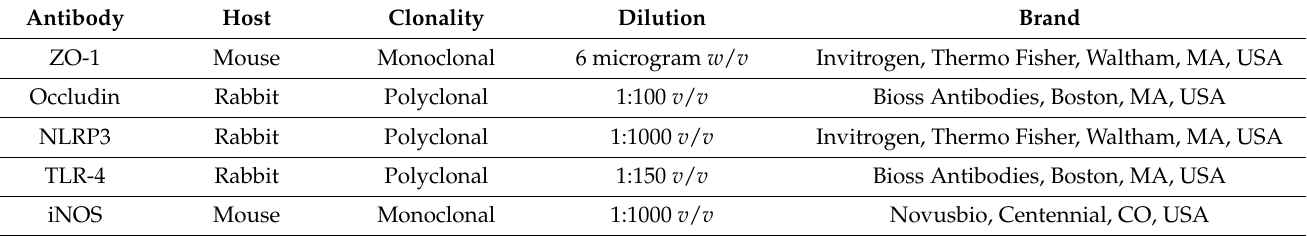
Table 1. Primary antibodies used in immunofluorescence analyses on cryo-sectioned colon